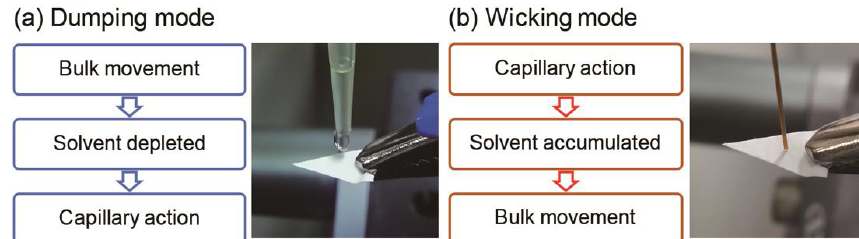
Figure 3. Analyte transportation processes taking place in paper spray ionization mass spectrometry, depending on the method of solvent application. ( a ) In the dumping mode, analyte transportation via bulk solution movement takes place during the early stages. As PSI proceeds, the spraying solvent becomes depleted, and capillary action becomes the dominant mode of analyte transport. ( b ) In the wicking mode, analytes are transported via capillary action during the early stages. As PSI proceeds, the spraying solvent becomes accumulated, and analyte transportation via bulk solution movement is